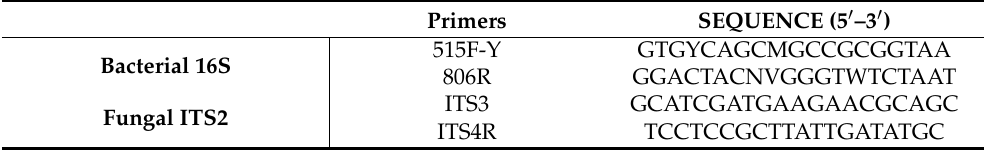
Table 1. Locus-specific primer sequences. Primers SEQUENCE (5 (cid:48) –3 (cid:48)